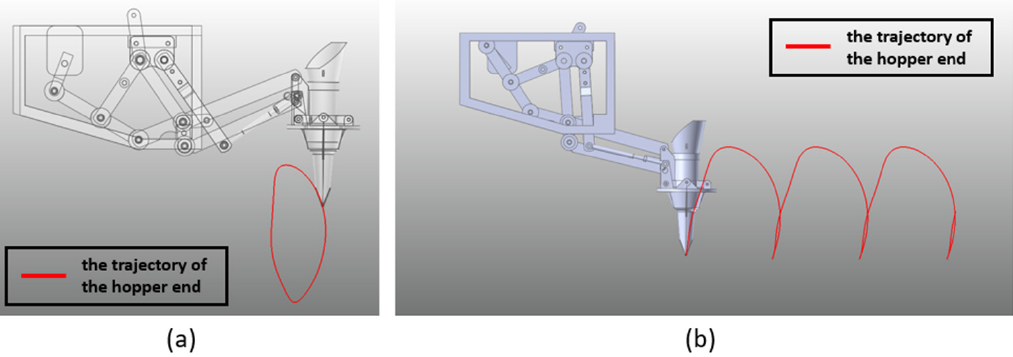
Figure 2. The trajectory of the hopper end of the transplanting device: ( a ) at stationary condition, ( b ) at mobile condition.